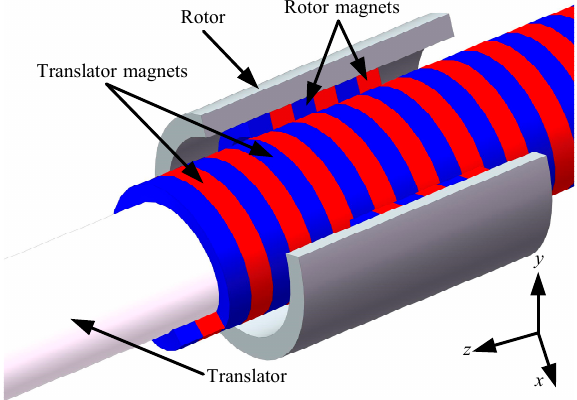
Figure 1. Schematic view of traditional magnetic lead screw (MLS).